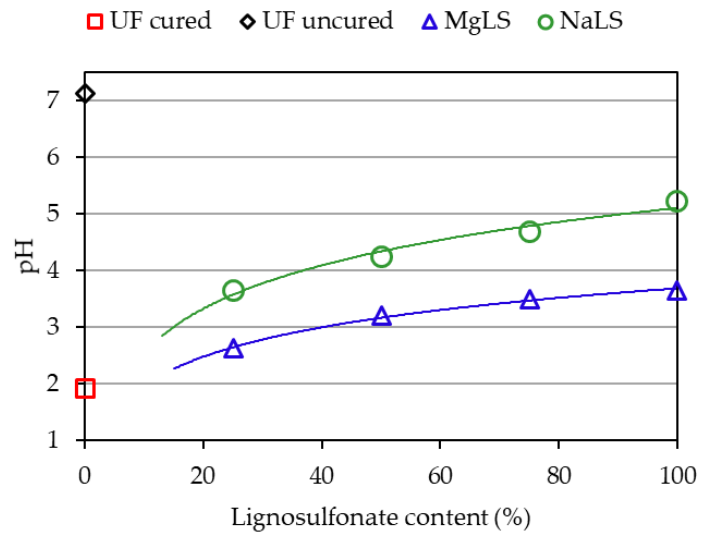
Figure 4. pH of cured UF compositions as a function of lignosulfonate content.